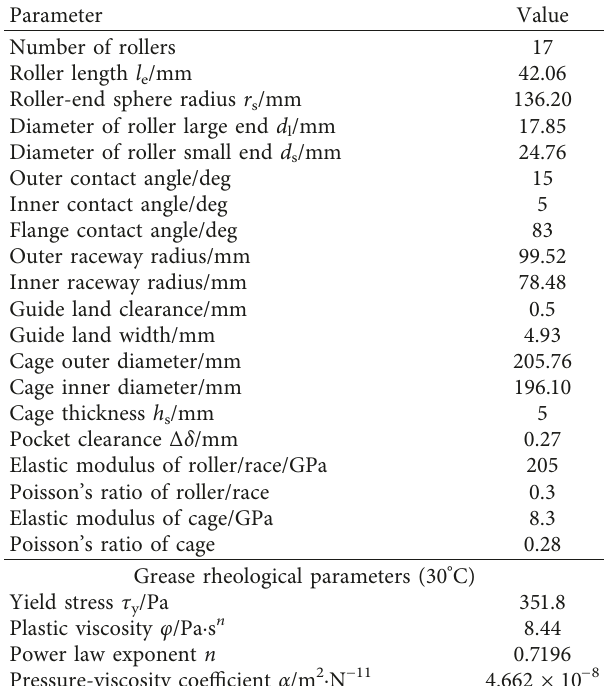
Table 1: Geometry, material and rheological